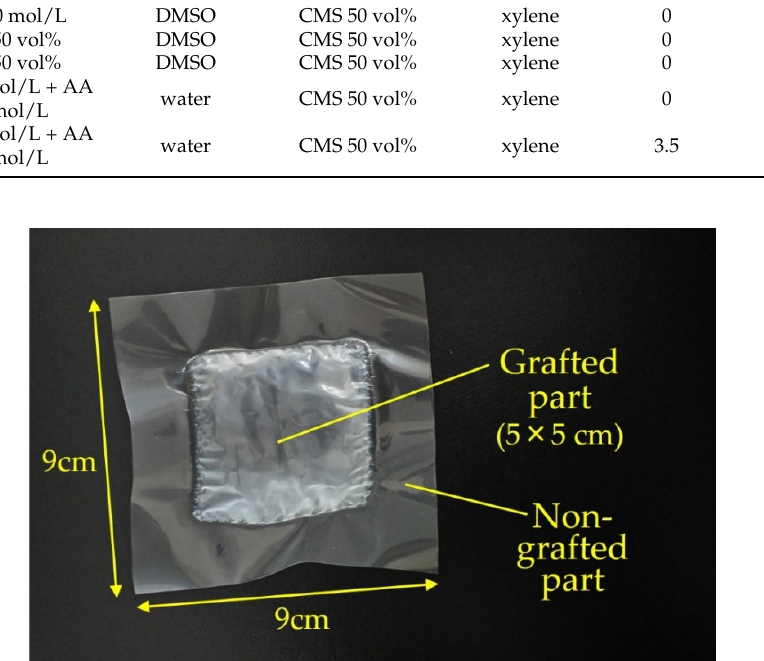
Figure 3. Picture of the grafted film prepared by RIAGP of sodium p -styrenesulfonate (SSS) and chloromethyl styrene (CMS) into a base poly(vinylidene fluoride) (PVDF) film (Run 1 in Table 4). In Runs 2 and 3, the monomer/solvent combinations of EtSS/DMSO and CMS/xylene were chosen for PVDF and ETFE (Route (ii) in Figure 2). The grafted films prepared in Runs 2 and 3 had thicknesses of 71 and 72 µ m with DOG eff of 121 and 95.8%